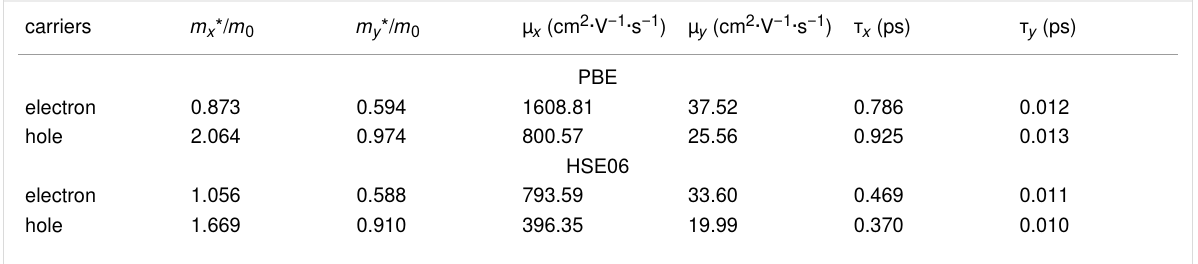
Table 1: The effective mass ( m *), carrier mobility ( μ ) and relaxation time ( τ ) along the x - and the y -directions of the MoO 3 monolayer at 300 K.